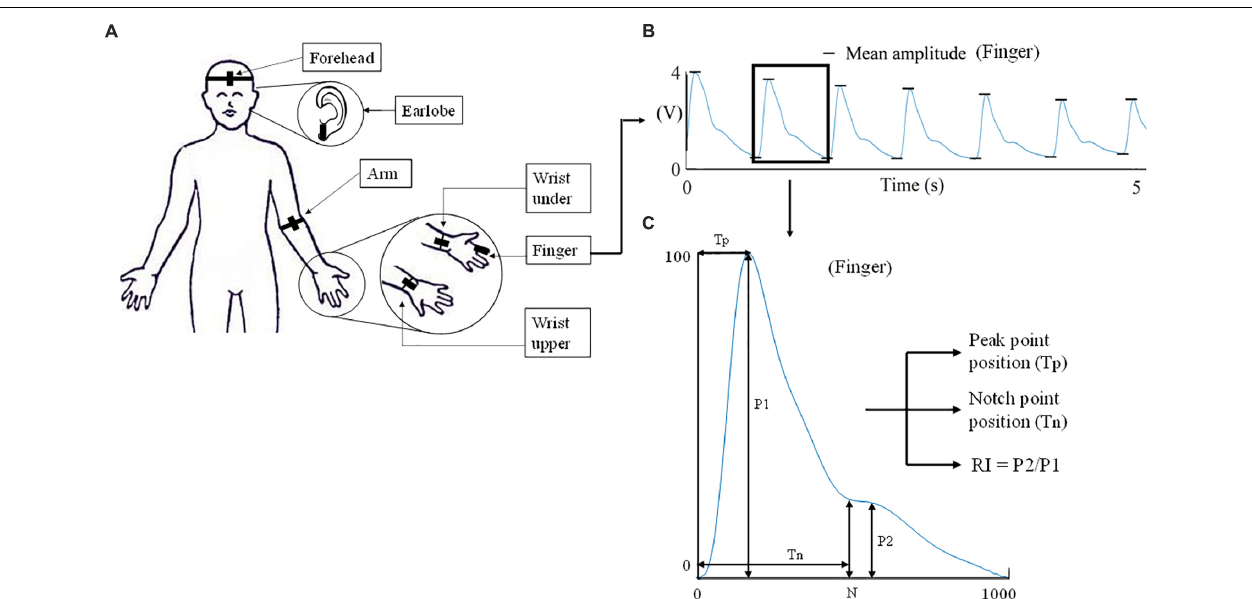
FIGURE 1 | Experimental protocol of PPG waveform recording and definition of waveform characteristics. (A) The six measurement sites (finger, wrist under, wrist upper, arm, earlobe, and forehead). (B) A 5-s segment of the waveform measured from finger. The extraction of mean amplitude is also illustrated. (C) The characteristics derived from the normalized PPG